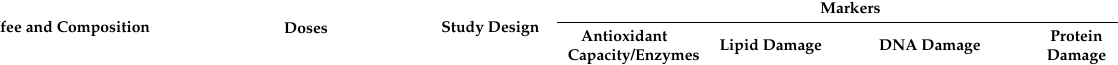
Antioxidant Capacity/Enzymes Lipid Damage DNA Damage